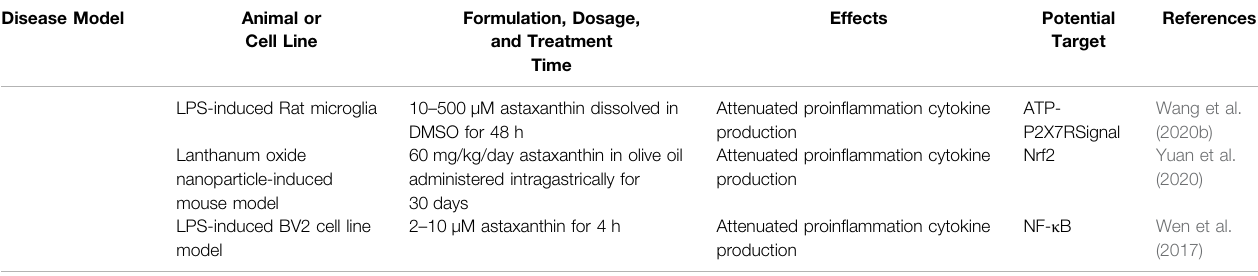
TABLE 1 | ( Continued ) Effects and potential mechanisms of astaxanthin in modulating neuroin fl